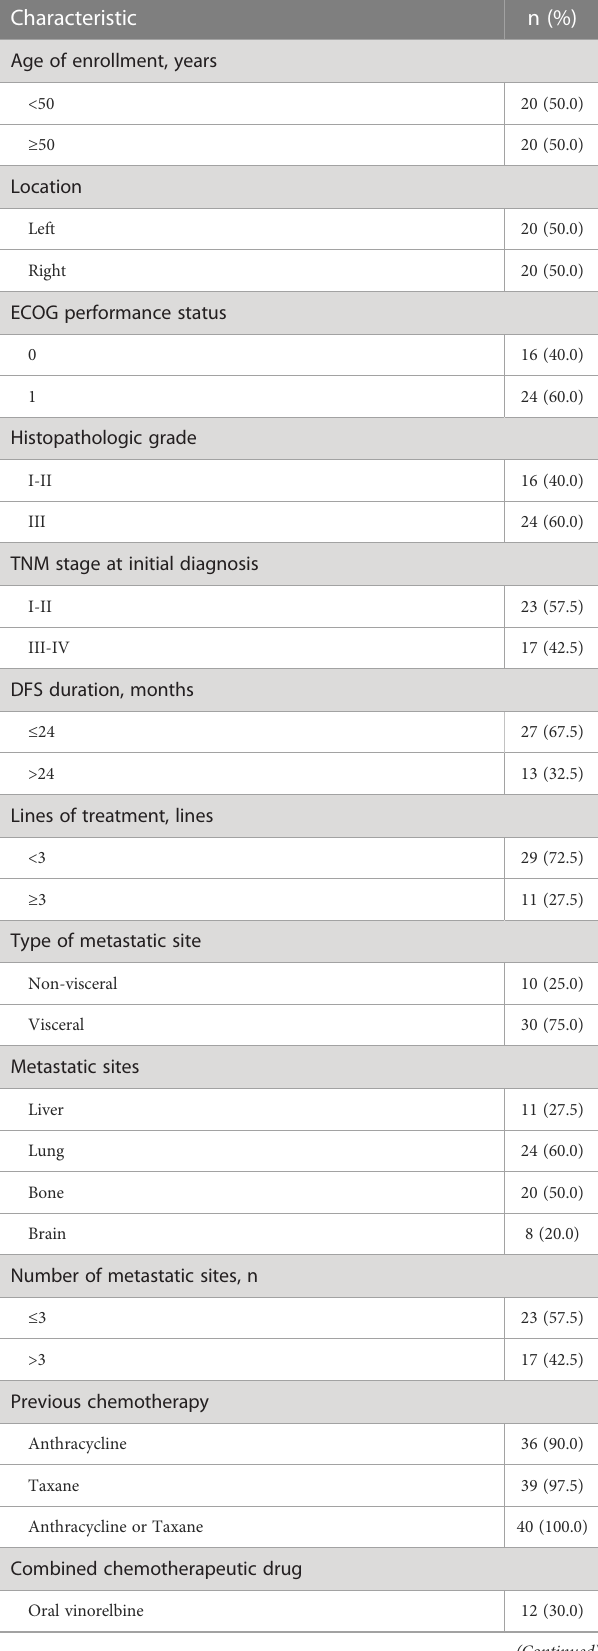
TABLE 1 Patient characteristics at